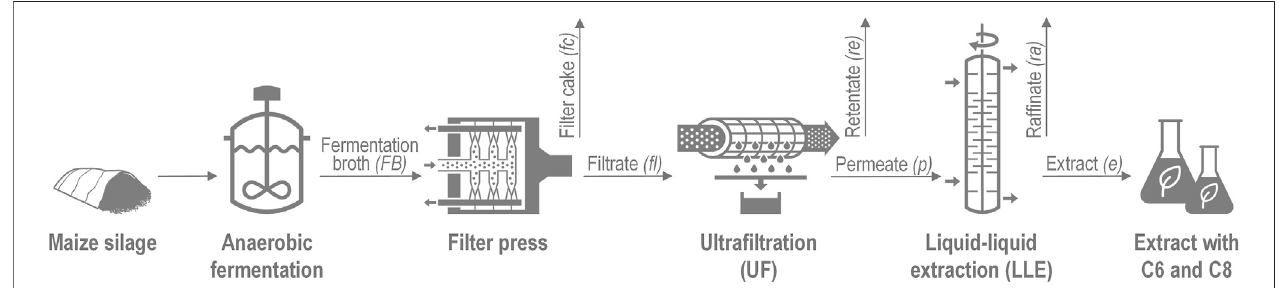
FIGURE 1 | Proposed downstream processing cascade for separation of caproic (C6) and caprylic acid (C8) from fermentation broth obtained by anaerobic fermentation of maize silage.